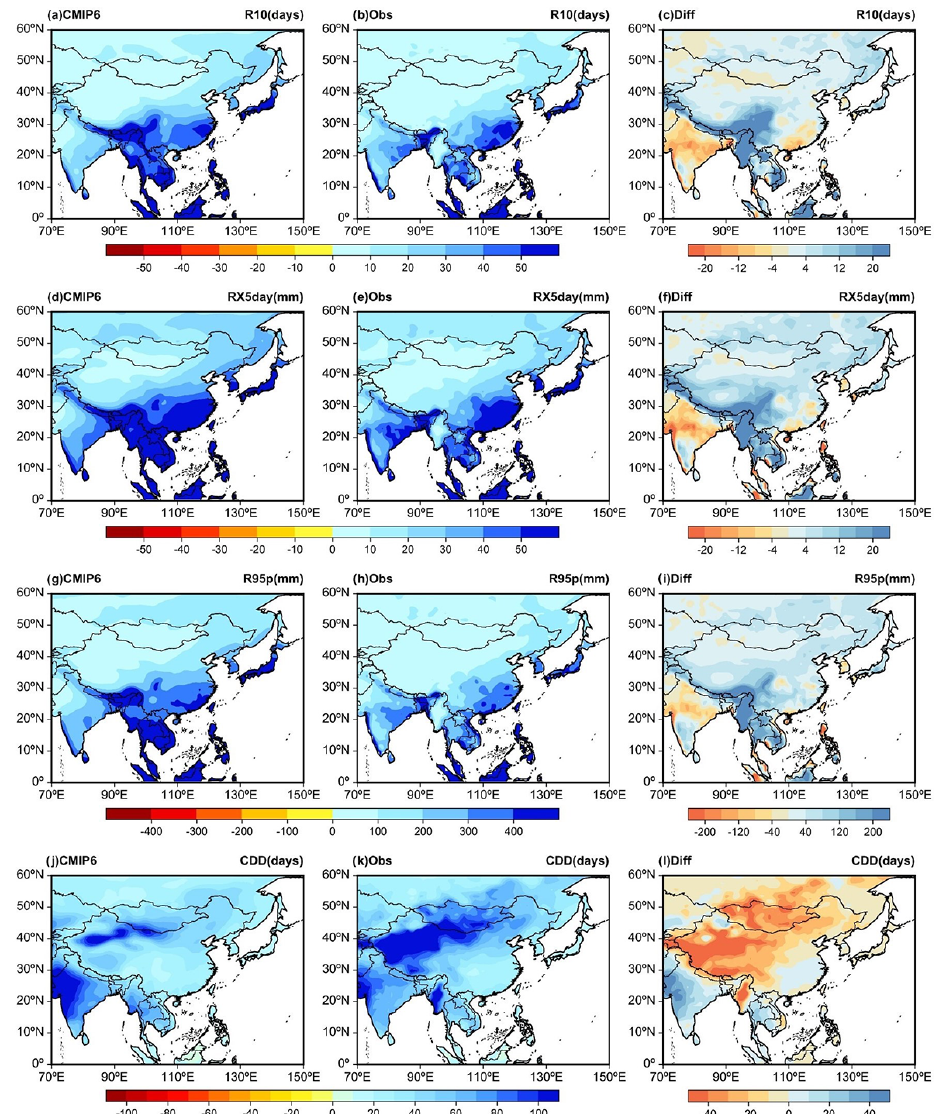
Figure 3. The annual mean of heavy precipitation (R10), maximum consecutive 5d precipitation (RX5day), total wet-day precipitation (R95p), and consecutive dry days (CDDs) over the study area during 1995–2014 for the CMIP6 multi-model mean ( a, d, g, j ) and gridded observations ( b, e, h, k ). The right column ( c, f, i, l ) represents the difference between CMIP6 and